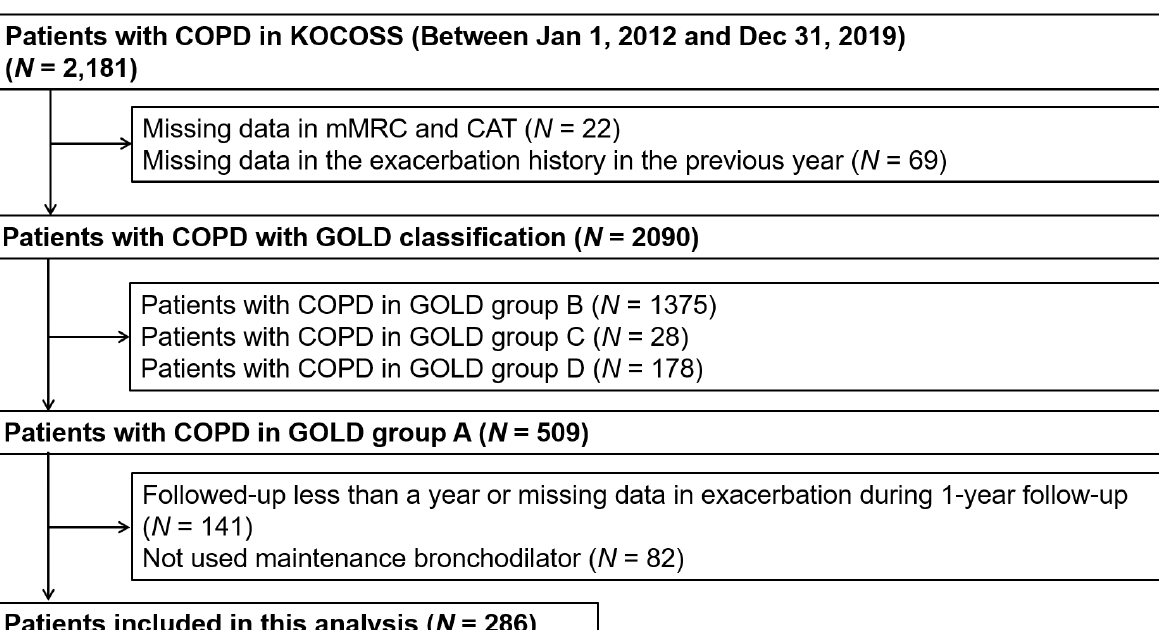
Figure 1. Selection of subjects. COPD: chronic obstructive pulmonary disease; GOLD: Global Initiative for Chronic Obstructive Lung Disease.